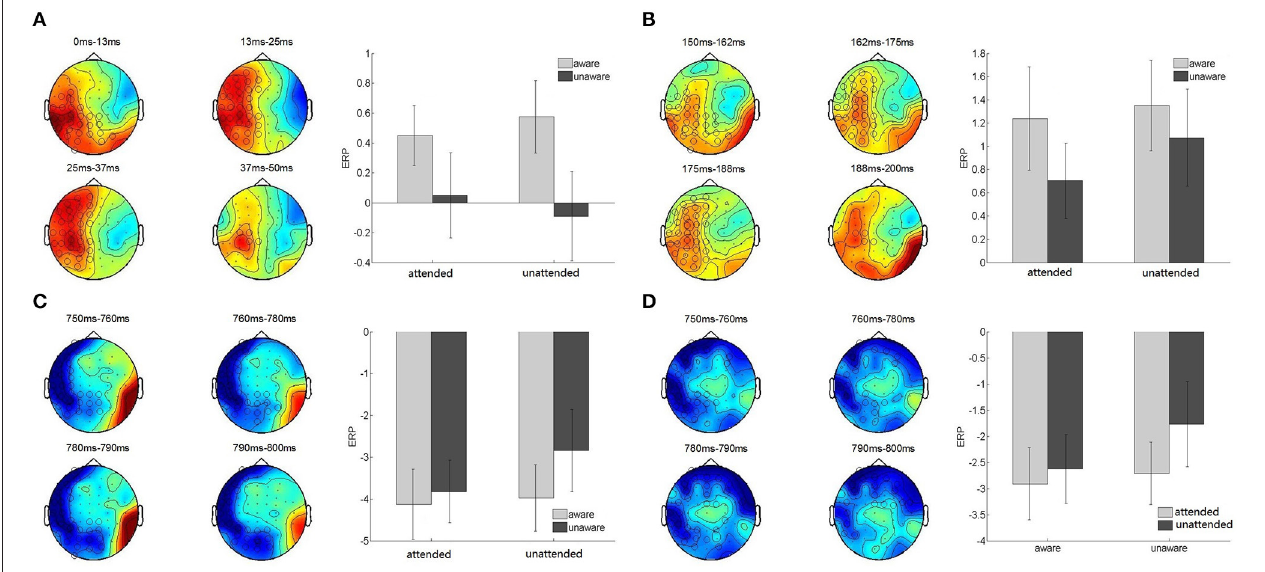
FIGURE 3 | Attention and awareness related clusters. (A–C) Awareness-related effects in the 0–50, 150–200, and 750–800ms post-cue presentation time period. Left, topographical distribution of the significant awareness-related clusters. The color map corresponds to the amplitude of the difference between aware and unaware trials, averaged over the corresponding time-window. Sensors activated in the significant awareness-related clusters are indicated by open circles. Diameters of the open circles are proportional to the duration of the activation of the sensor in the cluster. Right, bar graphs of the averaged ERP activation in the significant positive (A,B) and negative (C) clusters in the four experimental conditions. Error bars indicate standard error of the mean. (D) Attention-related effect in the 750–800ms post-cue presentation time period. Left, topographical map of the difference between attended and unattended conditions, averaged over the corresponding time-window. Right, bar graph of the averaged ERP activation in the significant negative cluster in the four experimental conditions.